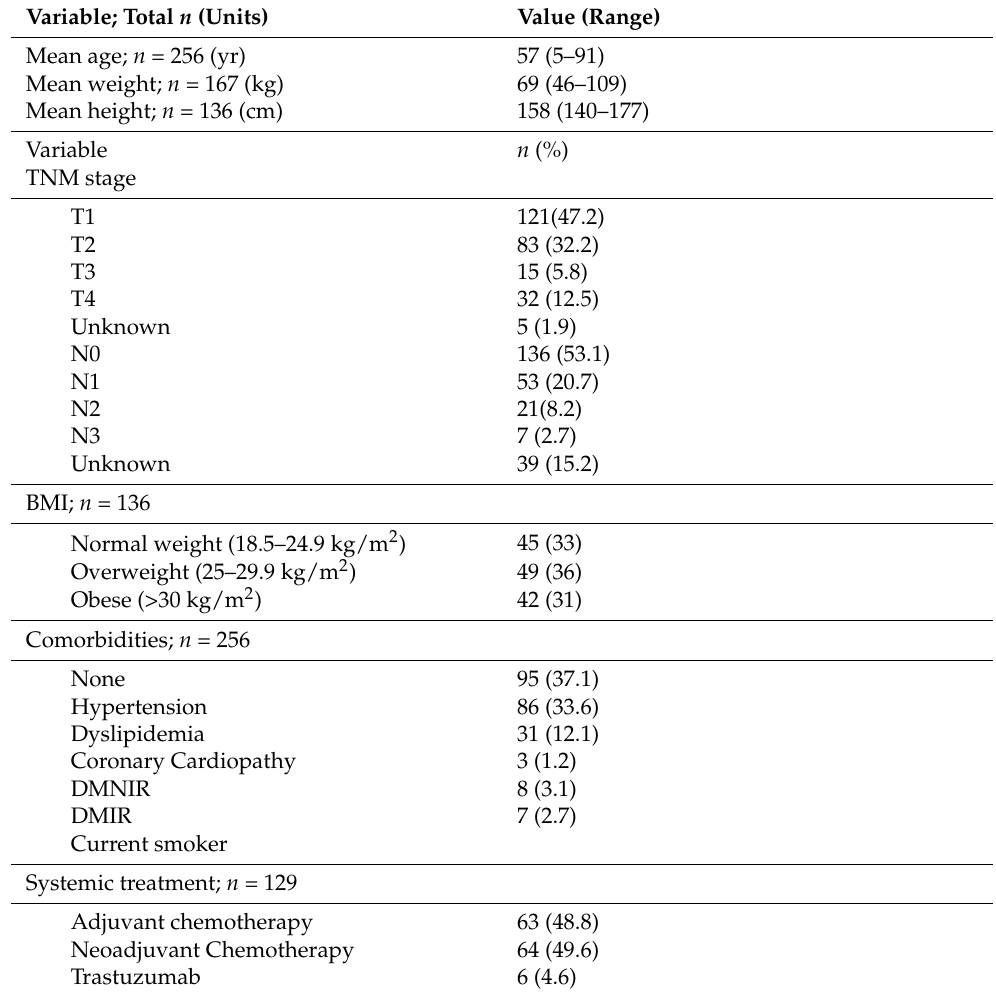
Table 1. Baseline patient